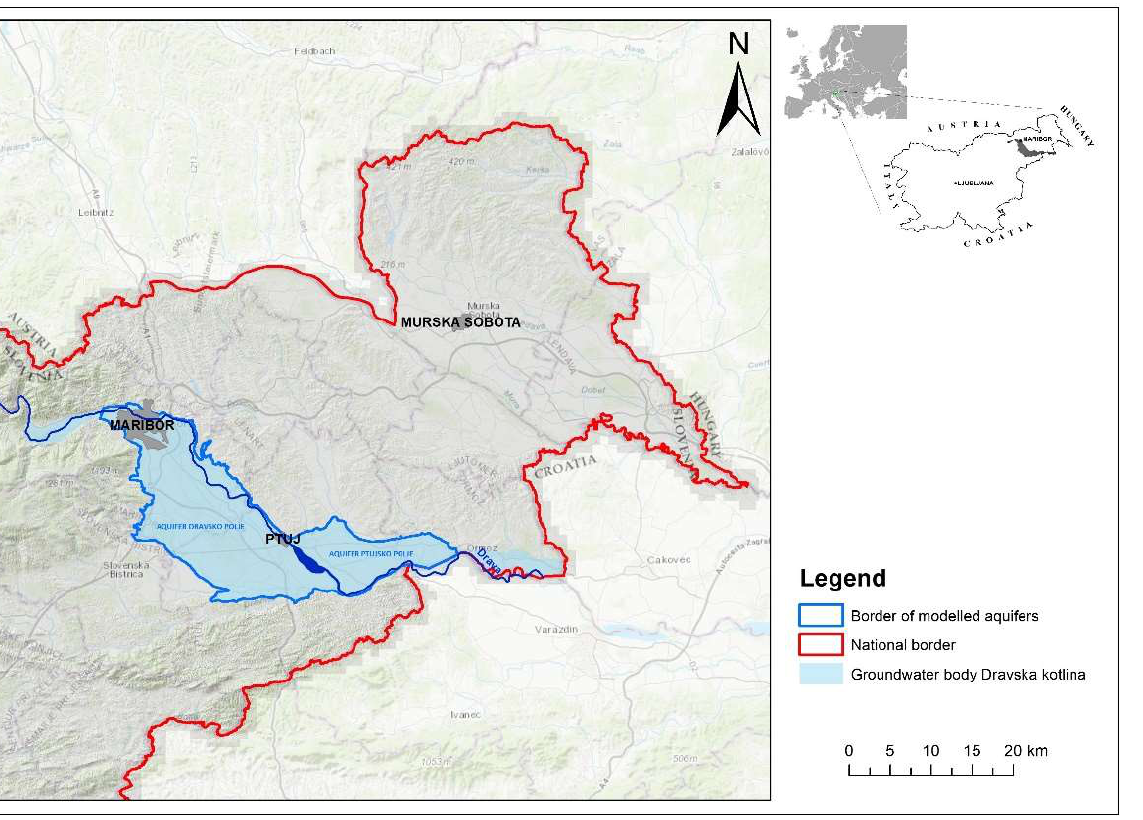
Figure 1. Dravska kotlina groundwater body with marked modelled aquifers.